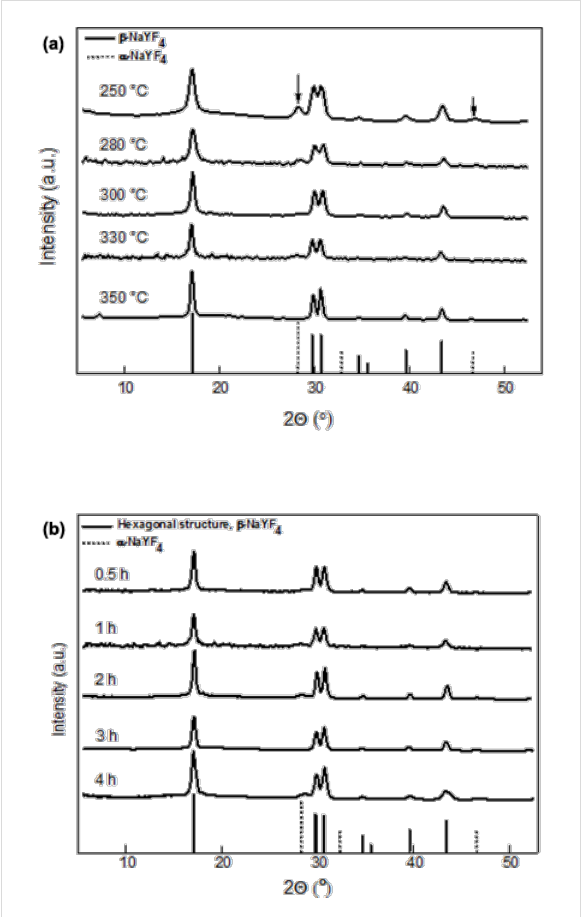
Figure 3: X-ray diffraction patterns of OM-NaYF 4 :Yb 3+ /Er 3+ : effect of (a) reaction temperature (time 1 h) and (b) time (temperature 330 °C). Lines corresponding to hexagonal and cubic phases were found in [36]. The arrows at the top of the image denote the most intensive diffractions of the cubic